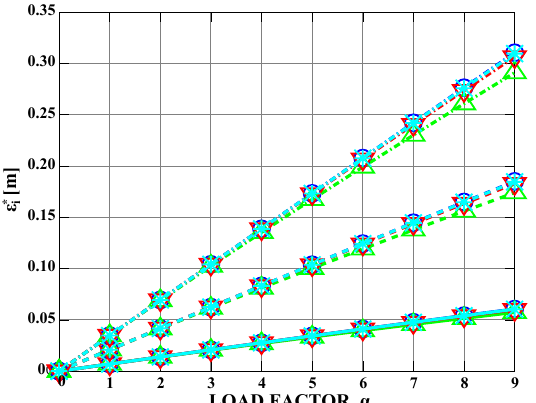
(solid line), ε ∗ 1 2